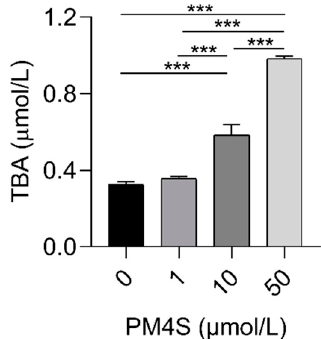
Figure 5. The TBA levels of pig primary hepatocytes culture medium with increasing dose of PM4S (0, 1, 10, and 50 μ mol/L), respectively. n = 3/group. Data are shown as means ± SE, *** p < 0.001.